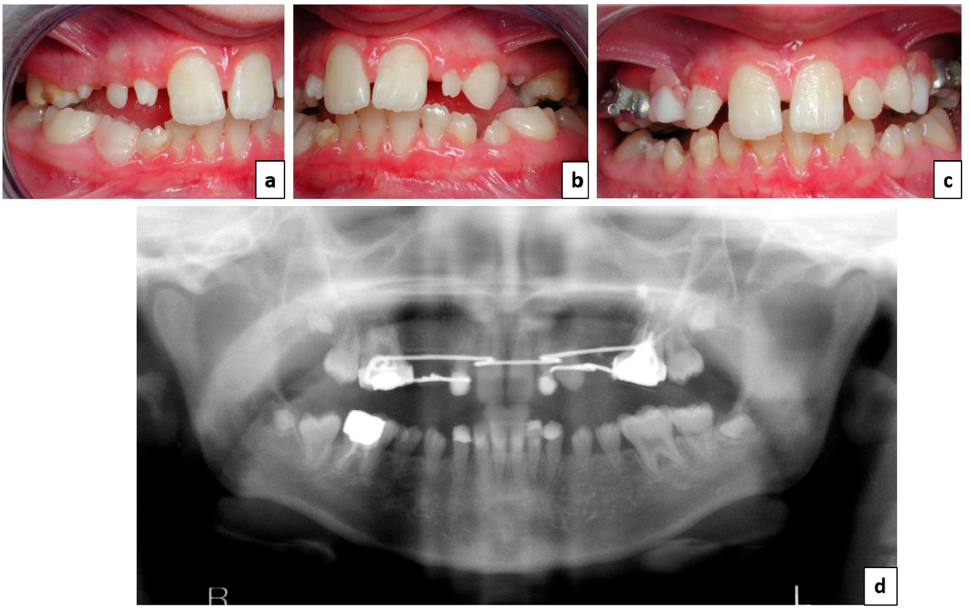
Figure 1. Situation and care provided during childhood. ( a , b ) Initial intraoral lateral views; ( c ) endobuccal view after additive coronoplasties and orthodontically retained interim prosthesis; and ( d ) panoramic X-ray of the situation.